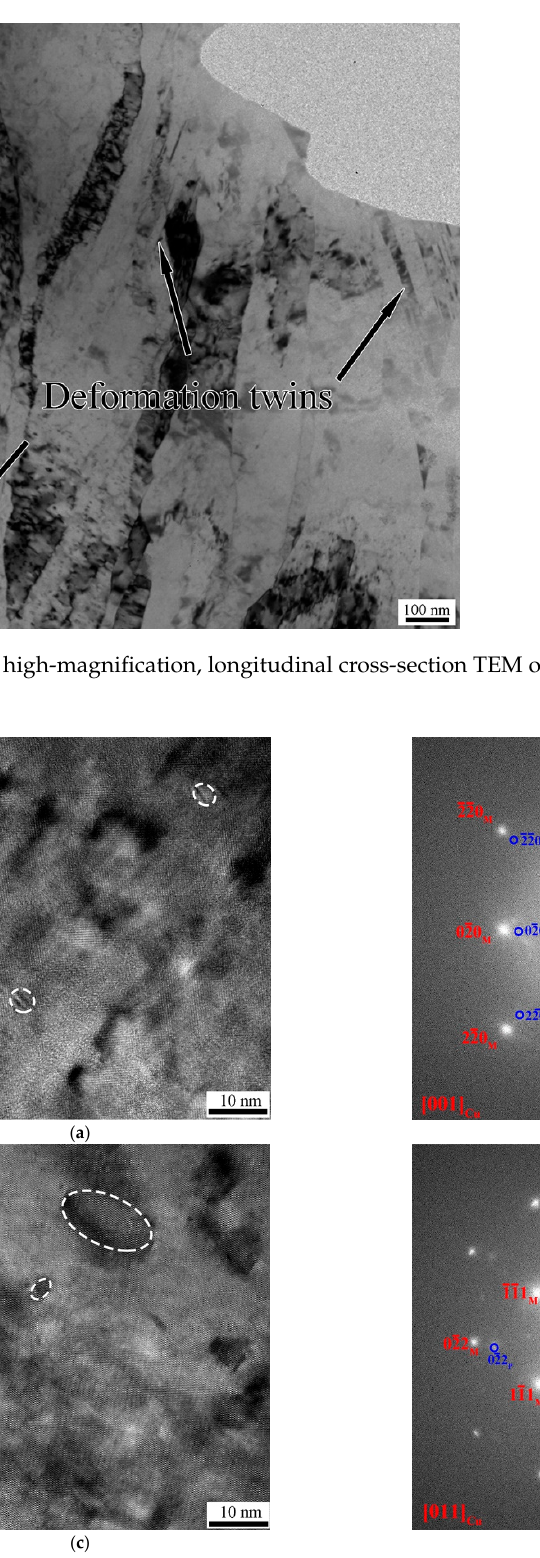
Figure 4. A longitudinal cross-section TEM observation of the aged Cu-0.4Cr-0.4Hf-S2. The inset shows the distribution of the deformation band width in the aged Cu-0.4Cr-0.4Hf-S2.